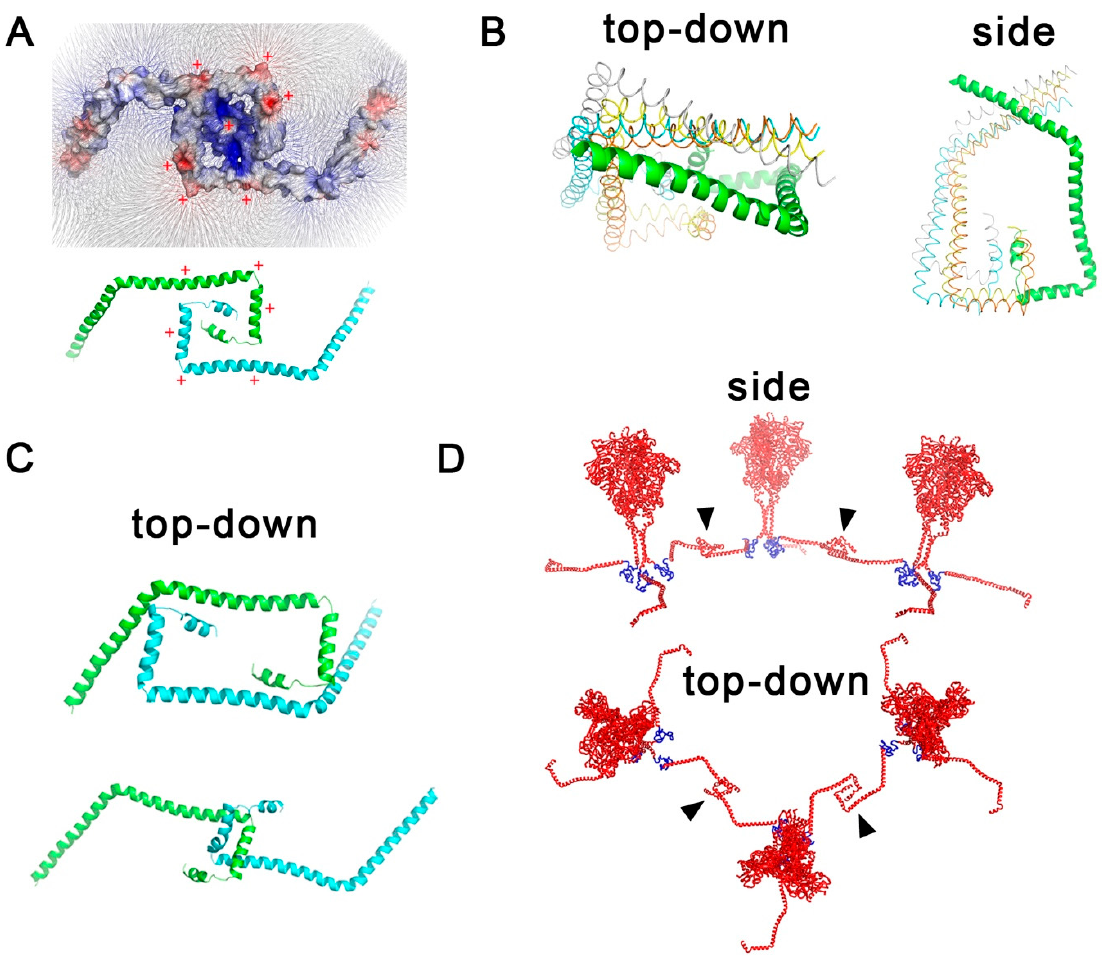
Figure 5. Interaction models of two or more Env CT domains from adjacent Env proteins. ( A ) APBS electrostatic analysis model. Positive residues are colored red and highlighted with positive signs. Blue residues are negatively charged. ( B ) Model showing the best four solutions determined with HDOCK. A “top ‐ down” view, as would be seen from outside of a virion, and a “side” view, as would be seen parallel to the membrane, are shown. ( C ) Models showing the best two solutions using ClusPro. Top ‐ down views are shown. ( D ) Side and top ‐ down views of three Env protein complexes interacting. Arrow heads show interacting segments within the CT domain.